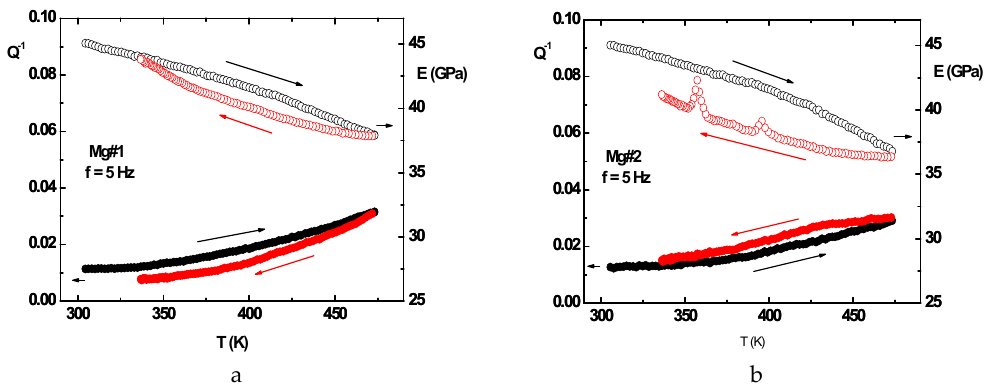
Figure 21. Anelastic spectroscopy traces recorded under 5 Hz excitation, of the elastic energy dissipation factor Q − 1 (dots) and Young modulus E (open circles) versus temperature (heating = black, cooling down = red) shown e.g., for ( a ) (left) Mg#1 sample (225 ◦ C, B C ECAP treated) and ( b ) (right) for Mg#2 sample (175 ◦ C, B C ECAP treated).